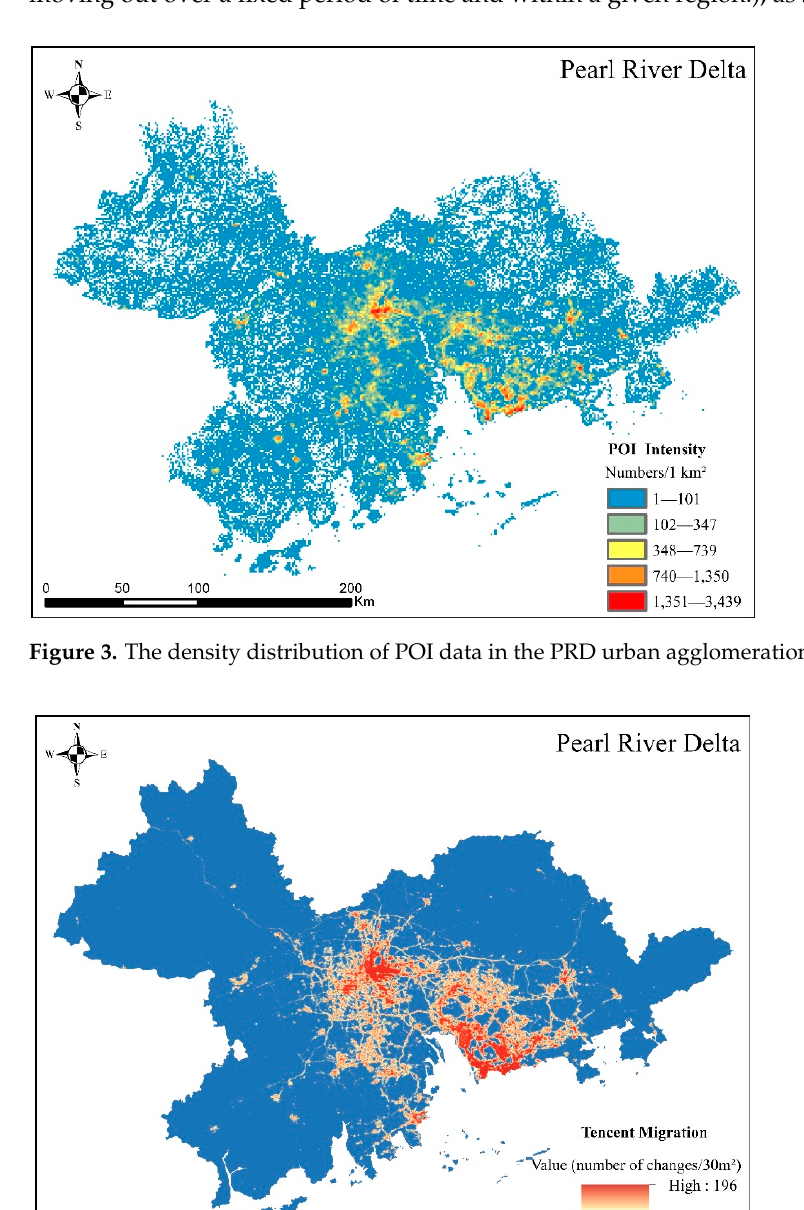
Figure 5. Population grid data of PRD urban agglomeration.